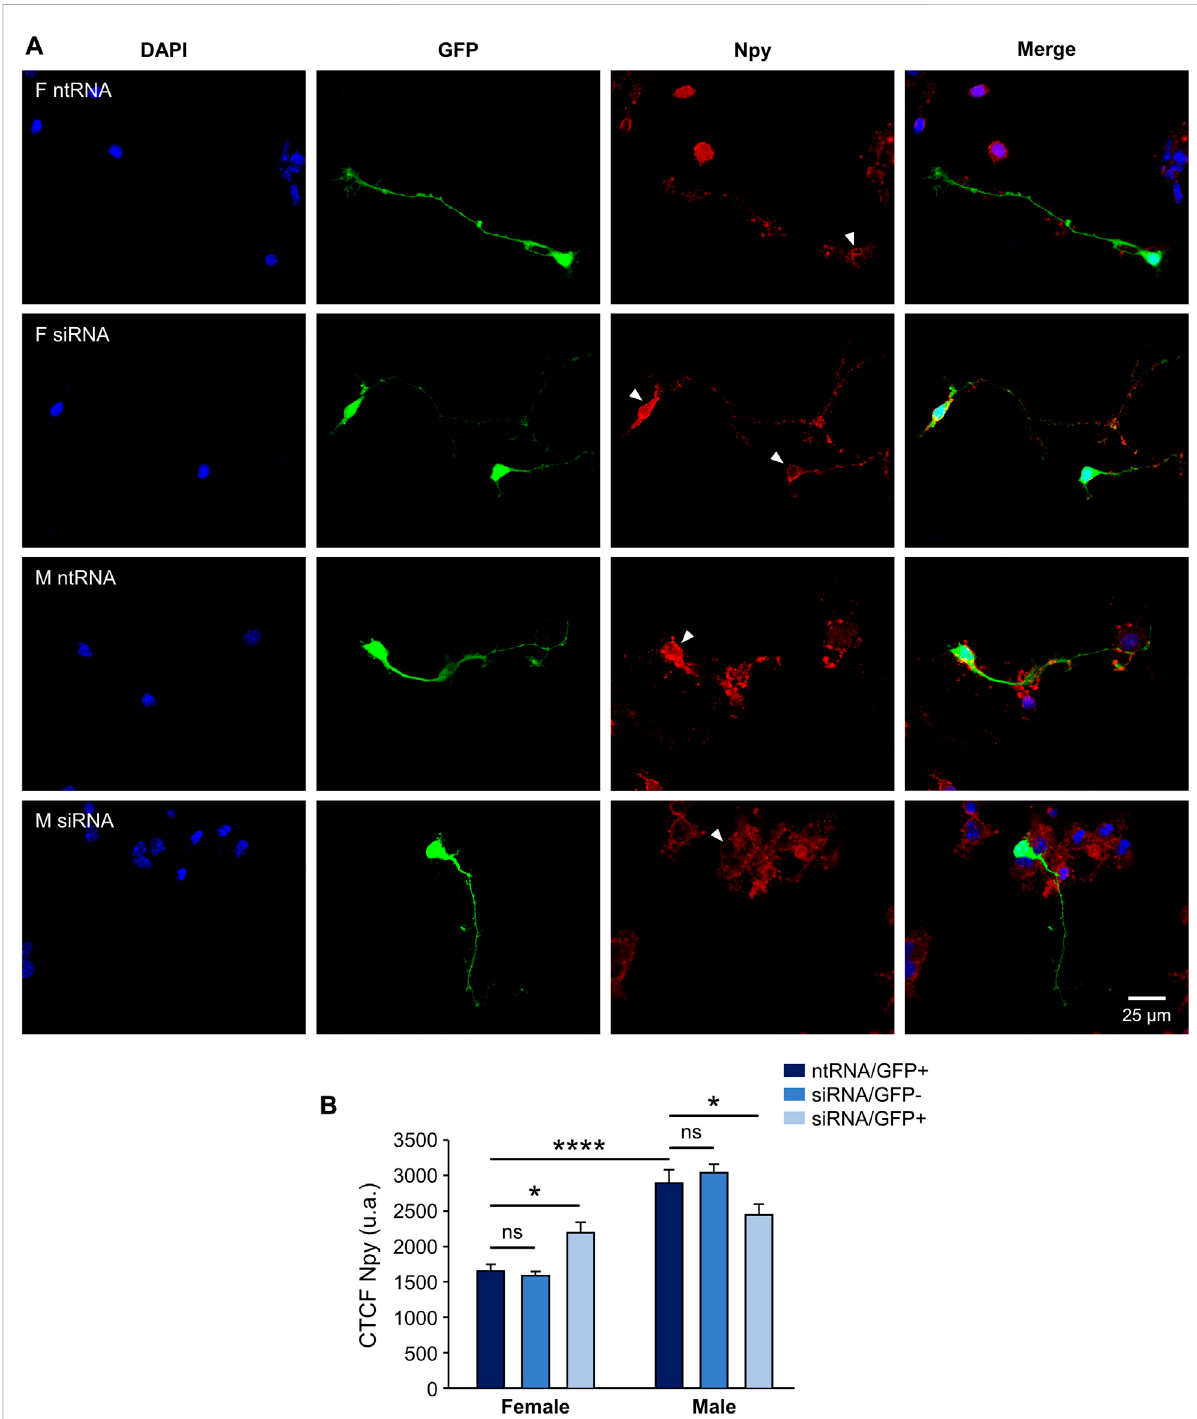
FIGURE 4 Kdm6a is required for Npy sexually dimorphic expression. (A) Representative fl uorescence images of female (F) and male (M) hypothalamic neurons co-transfected withanon-targeting siRNAsequence (ntRNA) andGFPor siRNAtargetingKdm6a (siRNA)and GFPatthreeDIVfor 18 h. Npy proteinexpression(red)wasdeterminedbyimmuno fl uorescencestainingintransfectedGFP+neurons(green).NucleiwerestainedwithDAPI(blue). Arrowheadspointtorepresentativemeasuredneuronalsomas. (B) Quanti fi cationof fl uorescenceintensityforNpyexpressedascorrectedtotal cell fl uorescence (CTCF). Npy expressed higher in male than in female hypothalamic neurons, and Kdm6a knockdown by siRNA increased the neuropeptideexpression infemaleswhiledecreasing itinmales. Dataare mean± SEM. n =60 – 90neuronsfromfourindependentculturesfor each sex and treatment. ns, not signi fi cant; * p < 0.05; **** p <